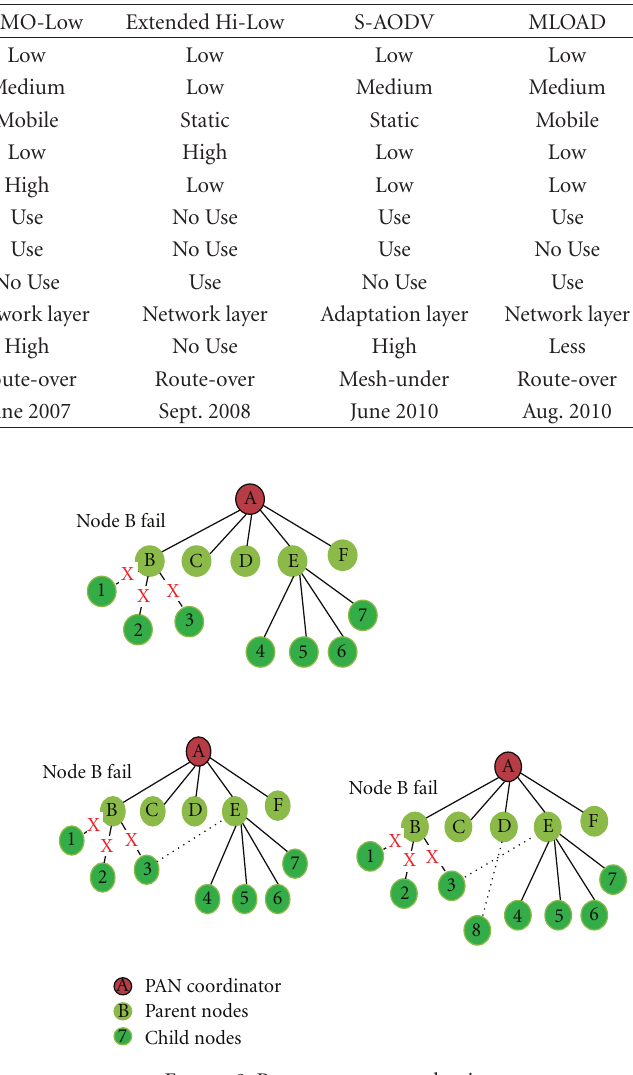
Figure 9: Route recovery